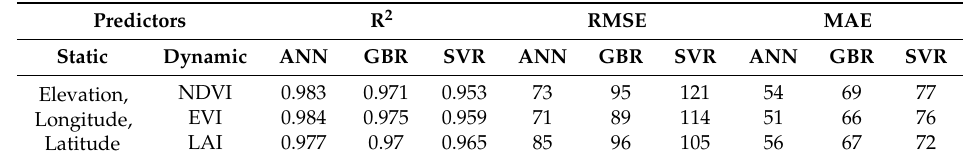
Table 1. Validation results of the machine learning-vegetation index compared to the original TRMM data for the year 2018.